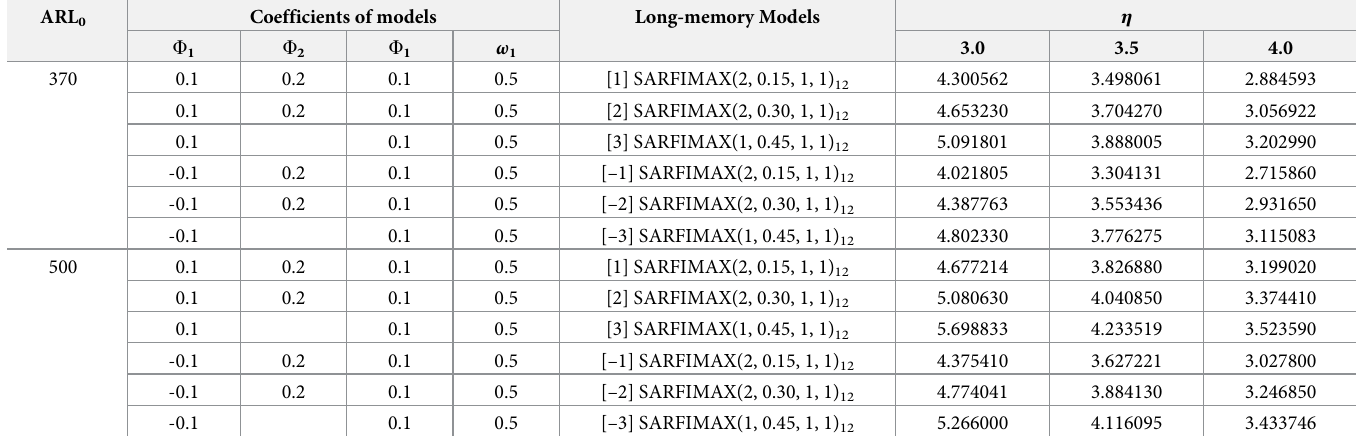
Table 1. Calculated b for corresponding reference parameter η values for a long-memory SARFIMAX( P , D , Q , r ) s process on a CUSUM control chart for ARL 0 = 370, 500. ARL 0